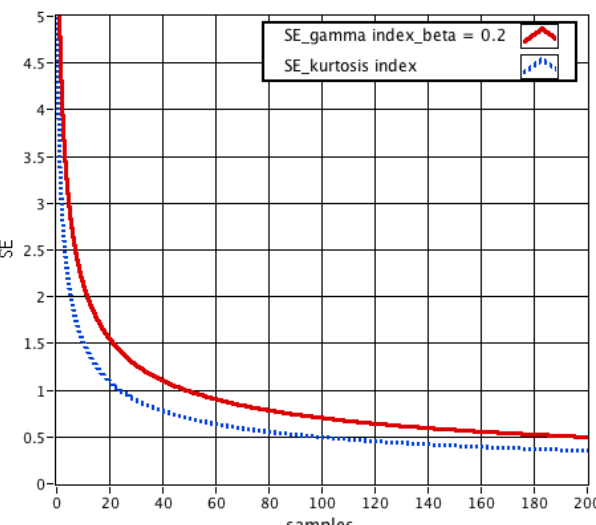
Figure 2: Comparison between SE different value of β